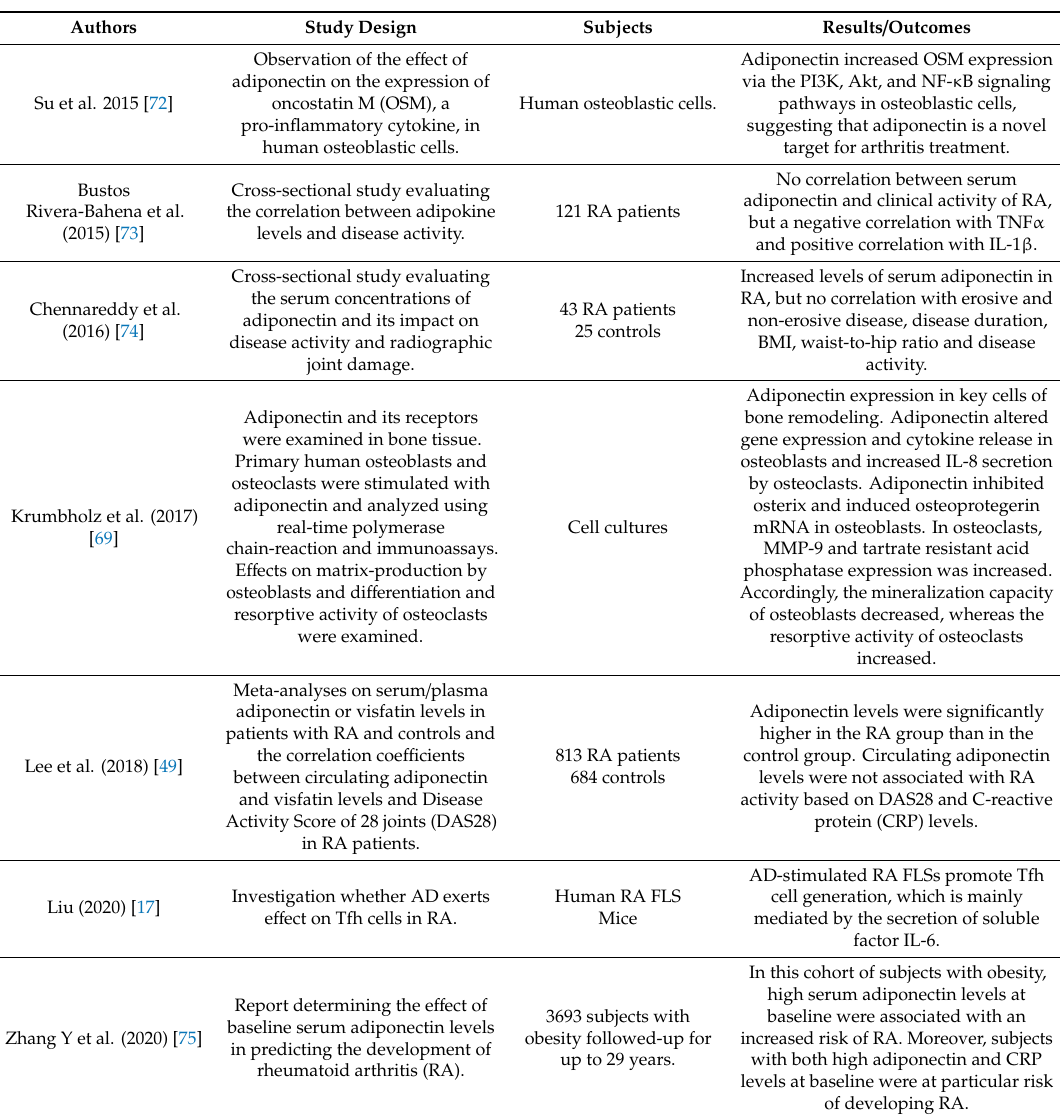
Table 1. Selected studies investigating the association of adiponectin and rheumatoid arthritis in humans, cell cultures, and